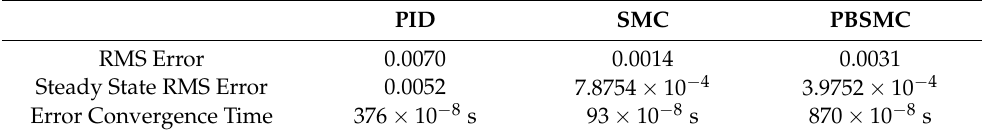
Table 6. Error Performance and Convergence Time for Controllers.